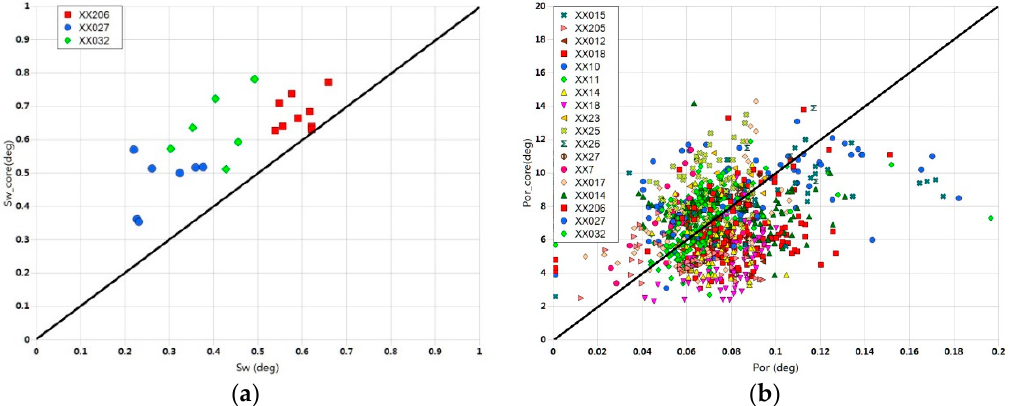
Figure 1. Comparisons between original logging interpretation results and core analysis results: ( a ) Water saturation; ( b ) porosity.